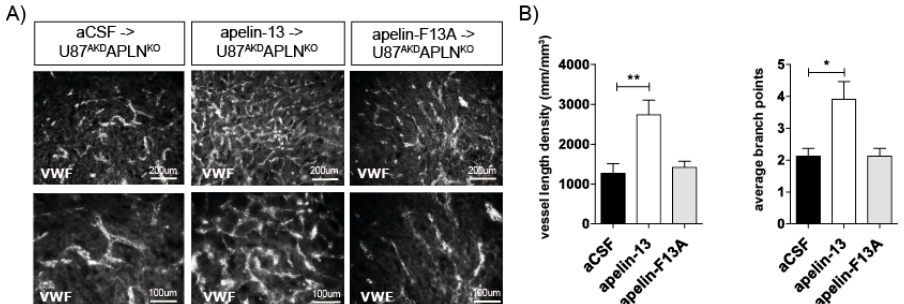
Figure 4. Apelin peptide rescues the vascular loss-of-function phenotype. ( A ) Intracerebral infusion of 30 µg of apelin-13 peptide ( n = 9) increased glioma angiogenesis in U87 AKD APLN KO xenografts compared to infusion of artificial cerebrospinal fluid (aCSF, n = 8) or apelin-F13A ( n = 6) antagonist as shown by von Willebrand factor (VWF) staining. ( B ) Quantification on a Stereoinvestigator resulted in a VLD of 1269 mm / mm 3 in U87 AKD APLN KO xenografts infused with aCSF only; 2573 mm / mm 3 with apelin-F13A. ABP obtained were 2.2; 3.9 and 2.2, respectively. Data are reported as mean +/ −